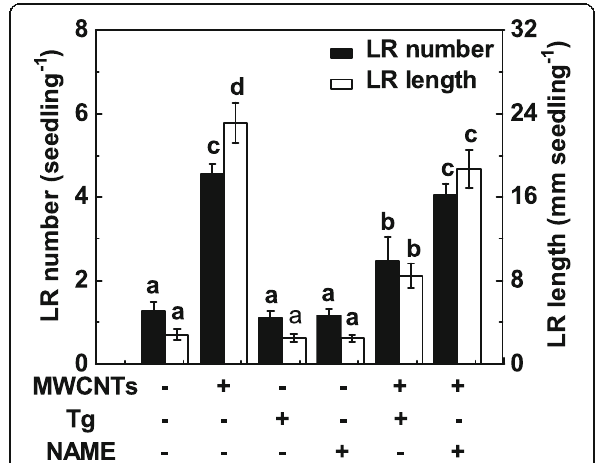
Fig. 6 Changes in LR formation in response to MWCNTs and two inhibitor of NO synthesis. Three-day-old tomato seedlings were treated with 5 mg/mL MWCNT, 20 μ M tungstate (Tg), 0.2 mM NAME, alone or in combination for 3 days. Afterwards, the number and length of emerged lateral root (> 1 mm) per seedling were then determined. There were 30 (10 × 3) plants in three biological replicates, and the experiments were conducted for 3 times. Data are the means± SE. Within each set of experiments, bars denoted by the same letter did not differ significantly at p < 0.05 level according